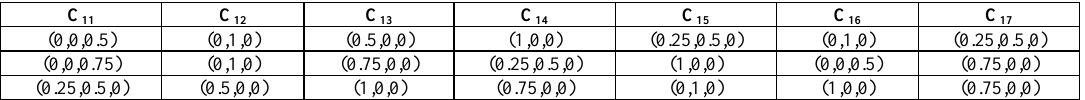
Table 12. The sub-criteria’s PFS of the criteria set C 1 .